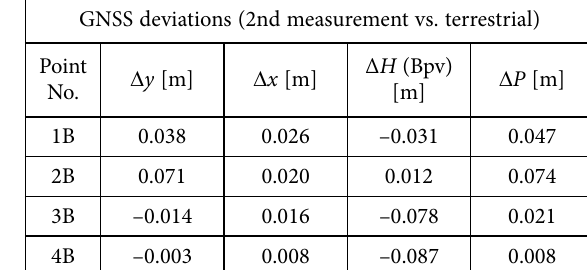
Table 4. Comparison of results (GNSS vs. terrestrial)